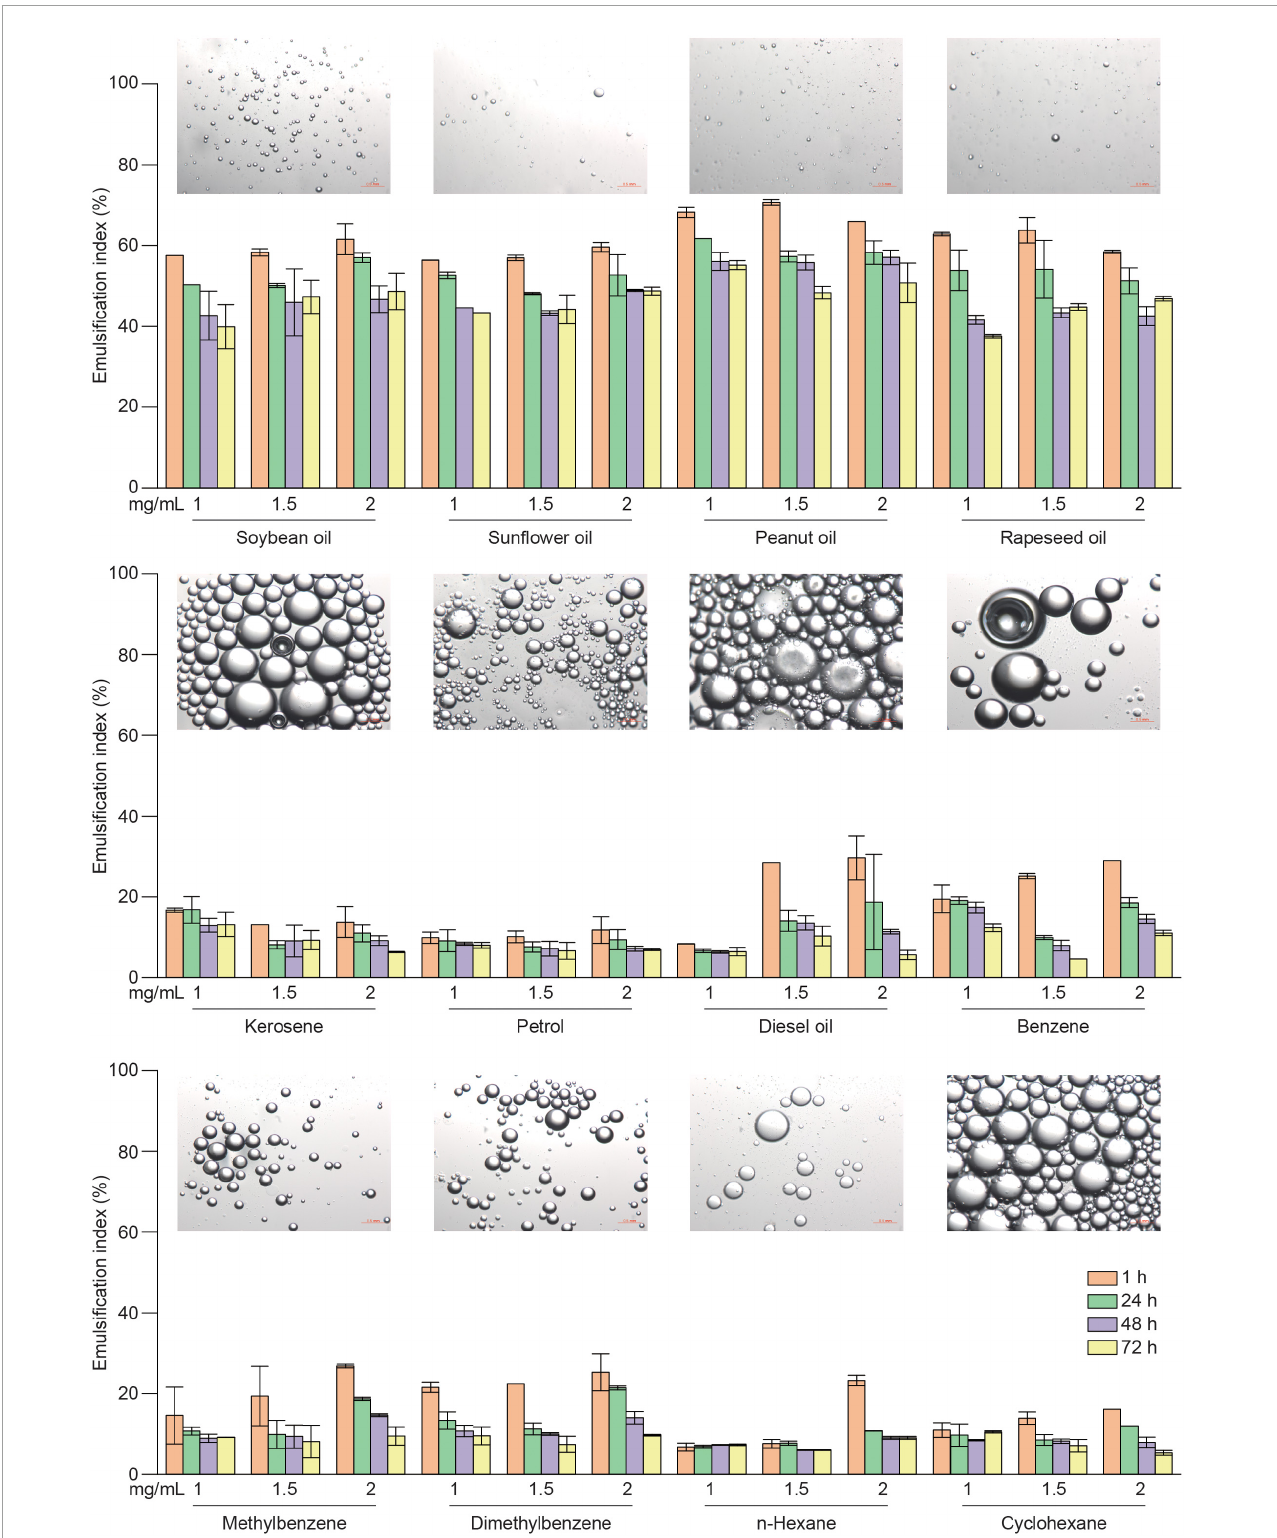
FIGURE9 Emulsification properties of Leu. mesenteroides RSG7 dextran in different concentrations with vegetable oils and hydrocarbons. Data represent the mean ± SD of three